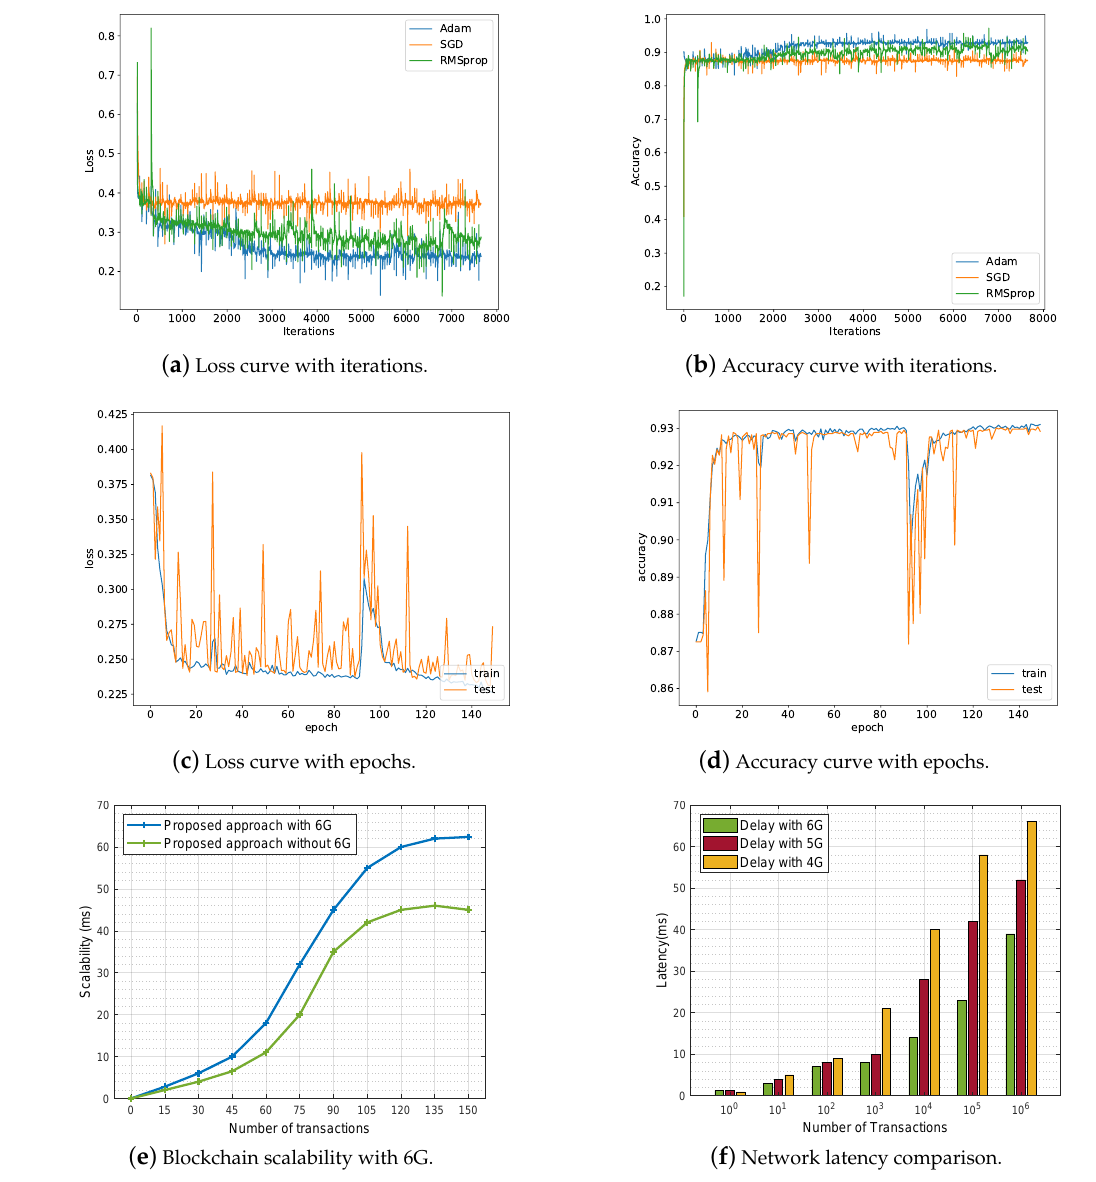
( d ) Accuracy curve with epochs.